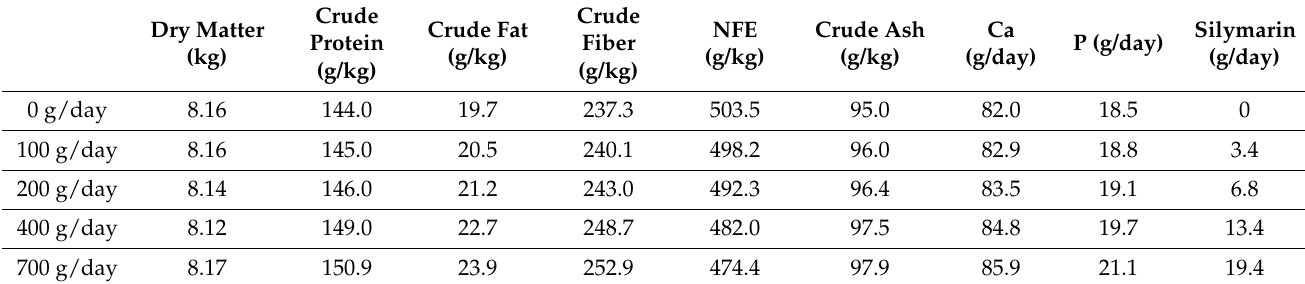
Table 3. The nutrient composition of feed with different proportions of milk thistle seed